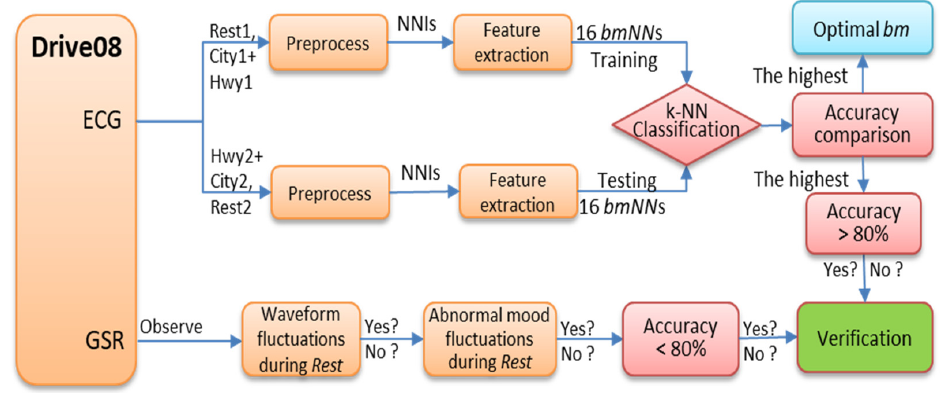
Figure 4. Block diagram of the heartbeat mode-based stress detection for Drive08 in the drivedb